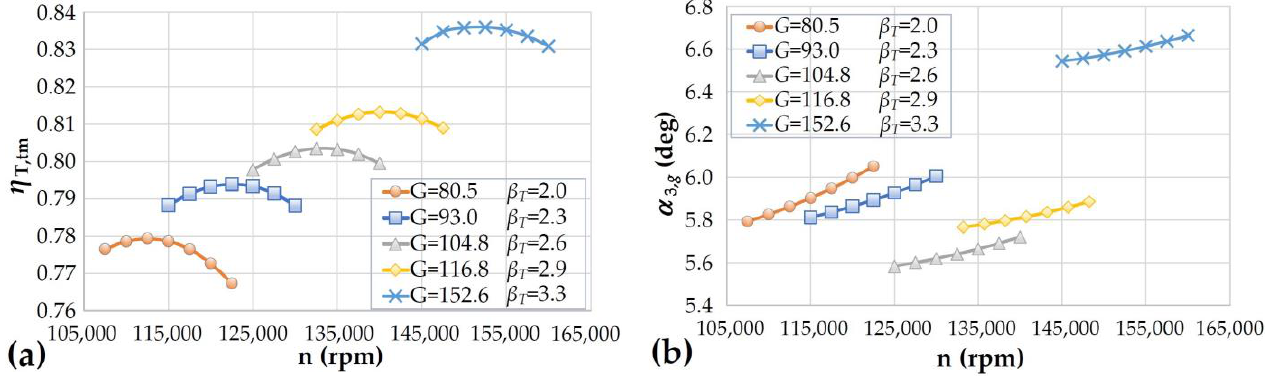
Figure 8. Turbine thermomechanical efficiency ( a ) and nozzle blade angle ( b ) as a function of rotor speed for different operating conditions of mass flow G (kg/h) and pressure ratio β T.